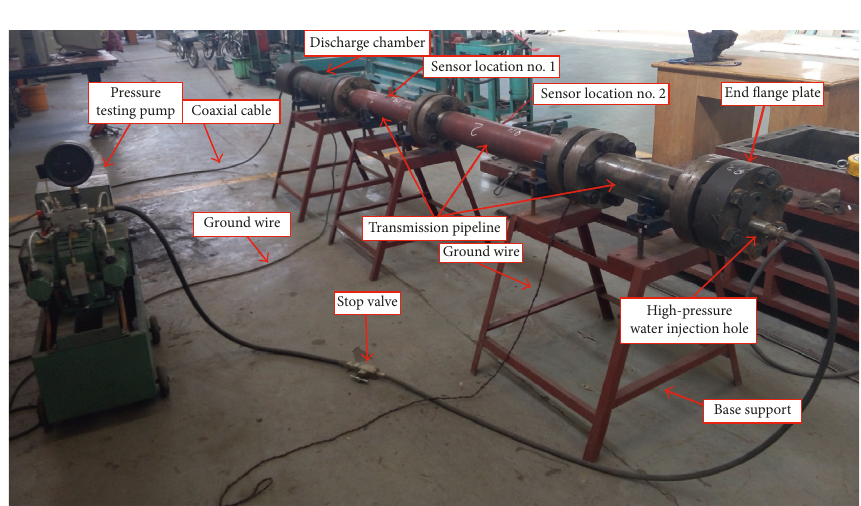
Figure 3: Photograph of the pressure-bearing pipeline